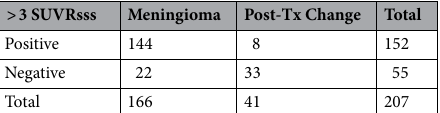
Table 5. Contingency table for the SUVRsss method at the pre-determined threshold of 3.